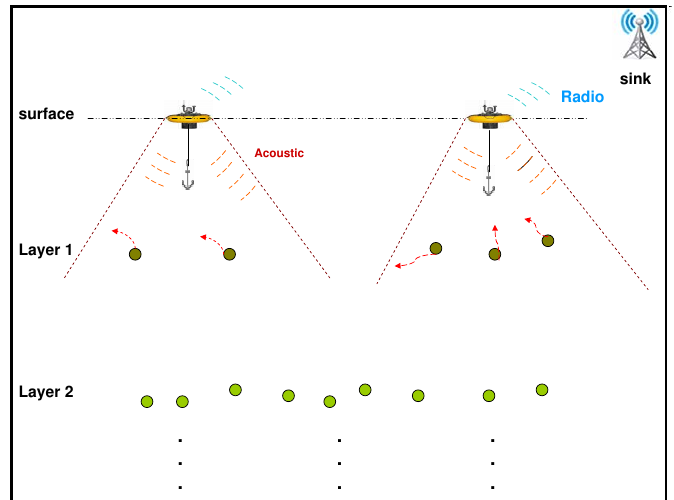
Figure 2. Network